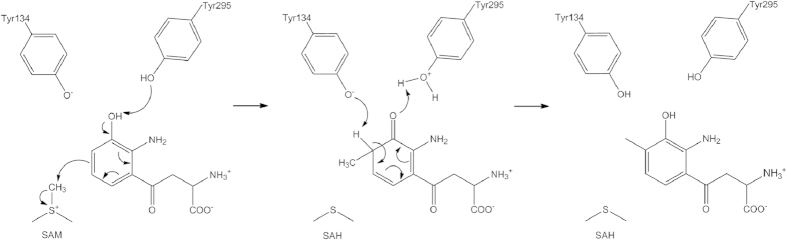
Proposed Ss-SibL C-methylation mechanism. Tyr134 and Tyr295 act as a tyrosine clamp to catalyze the transfer of methyl group from SAM to 3-HK.